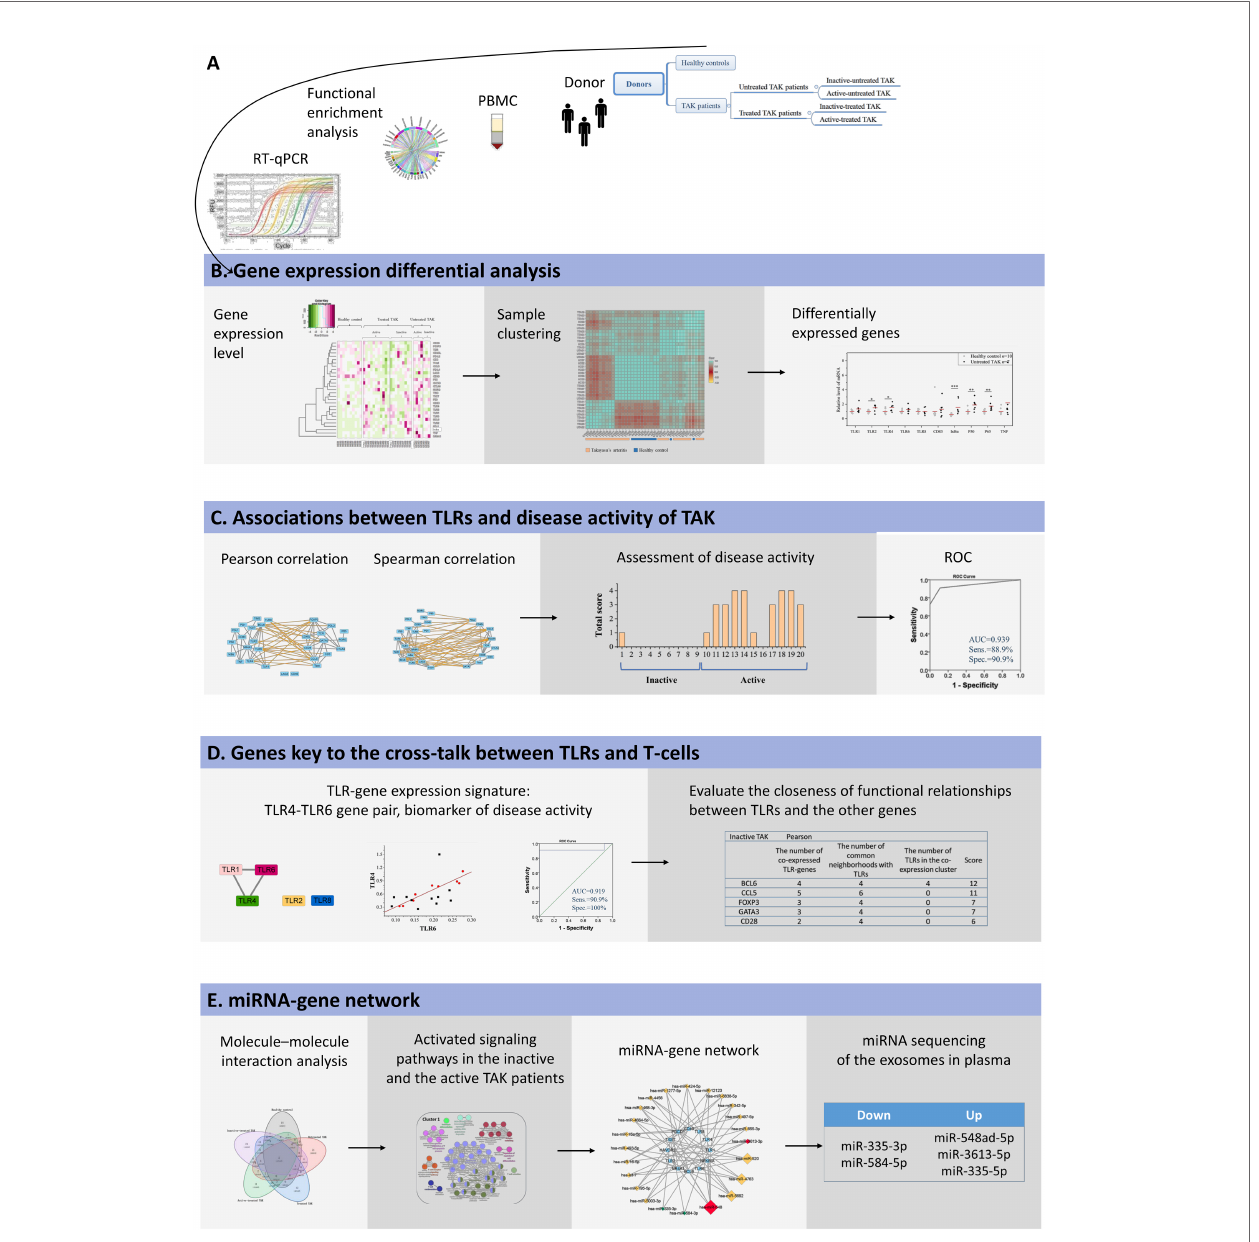
FIGURE 1 | The basic work fl ow of this study. (A) mRNA abundance of 29 target genes in PBMCs was measured using RT-qPCR, and these genes were highly enriched in TLR signaling pathways and the function of the activation and differentiation of T-cells by functional enrichment analysis. (B) Sample clustering analysis suggested that TAK patients had a different expression pattern of the selected genes from the healthy controls. Gene expression differential analysis demonstrated the upregulation of TLR signaling pathway in TAK, but no substantial difference in TLR signaling pathway was found between the inactive-treated TAK patients and the active-treated TAK patients. (C) Correlation analysis showed that the inactive-treated TAK group exhibited a unique pattern of inverse correlations between the TLRs gene cluster and the gene cluster associated with T-cell activation and differentiation, while the active-treated TAK group did not. And TLRs and their correlation cluster could distinguish active patients from inactive patients in TAK. (D) Dynamic gene co-expression network was constructed. TLR-co-expression signature of different stages was observed, and the degree of functional association between the other genes with TLRs was assessed. (E) To account for the co-expression in the greatest cluster of the inactive-treated TAK group, functional enrichment analysis, miRNA database prediction, and miRNA sequencing of plasma exosomes was performed, which indicated that miRNAs might play an important role in the cross-talk between TLR and T-cell in TAK